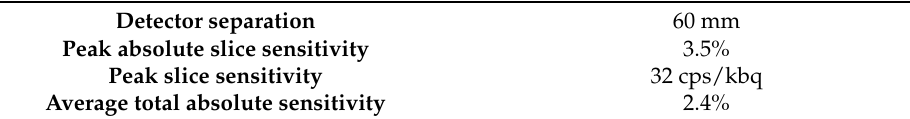
Figure 8. Axial absolute sensitivity plotted against point-source location along the X-axis. Table 2. The peak axial absolute sensitivity and the normalized total sensitivity for a 60 mm detector-head separation.